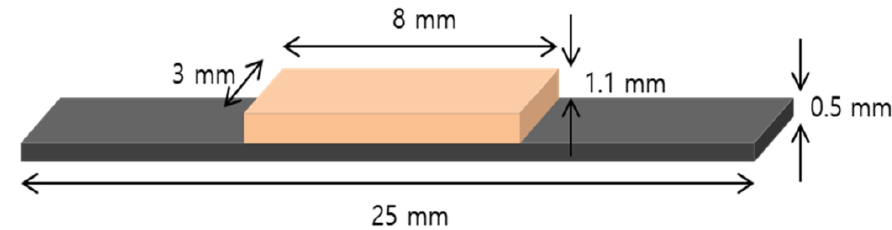
Figure 3. Schematic diagram of the shape of the Metal-Ceramic specimens. The orange part represents the veneering ceramic, and the black part represents the metal